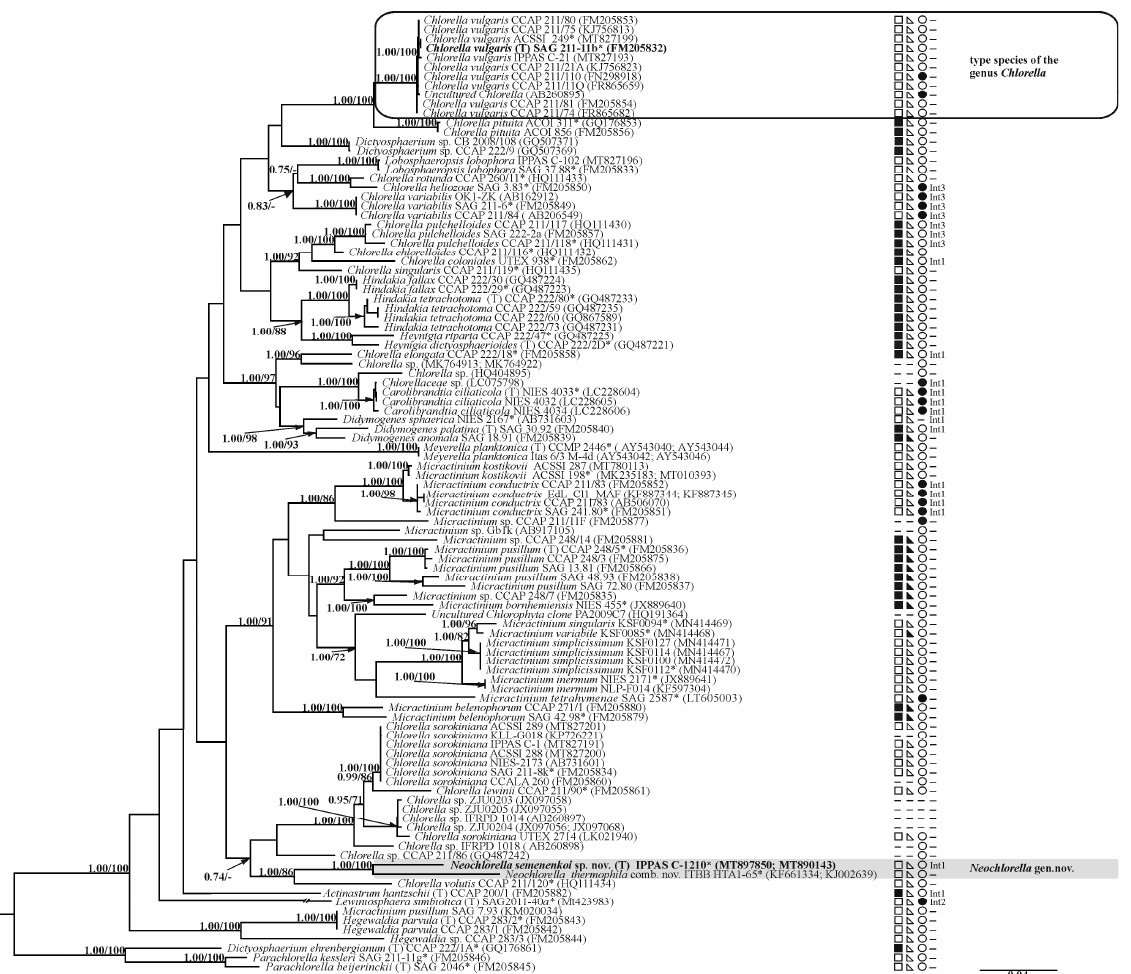
Figure 3. A Bayesian phylogenetic tree of the Chlorella clade (Trebouxiophyceae, Chlorophyta) based on the comparison of the nucleotide sequences of the SSU-ITS1-5.8S-ITS2 region (2611 bp). The support values are given for Bayesian Inference and Maximum Likelihood (PP/BP). The cut-off values for BI and ML are 0.7 and 70%, respectively. The model of nucleotide substitutions: GTR + I + G. The newly sequenced strain IPPAS C-1210 is highlighted in bold. Members of the genus Neochlorella gen. nov. are highlighted by a gray box. The strains of C. vulgaris , which is the type species of the genus Chlorella , are enclosed by a rectangle. The authentic strain C. vulgaris SAG 211-11b is in bold. Designations: *—authentic strain; T—type species; black square—forms colonies; white square—single cells; white triangle—does not produce bristles; black triangle—produces bristles; white circle—a free-living organism; black circle—an endosymbiotic organism; “ − ”—no information; Int—presence of introns, and the number of introns is indicated next to it; “–”—no intron. Scale bar: 0.04